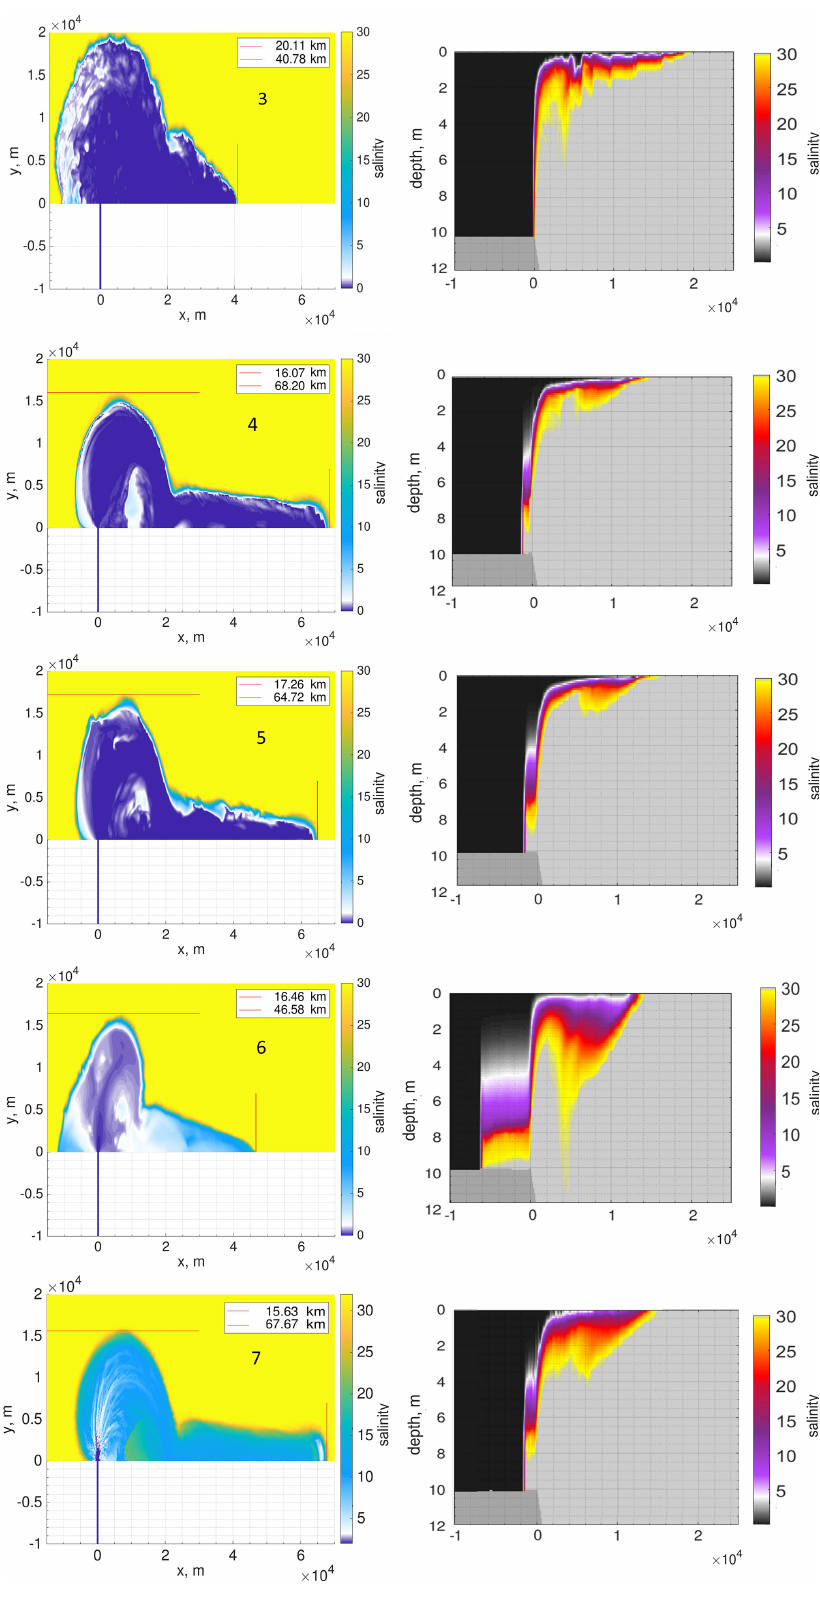
Figure 5. The surface salinity (left panels) and salinity at the mouth cross section (right panels), in practical scale, at 35h in different runs indicated by the number (see Table 1). The bulge offshore spreading and the coastal current propagation are shown by red